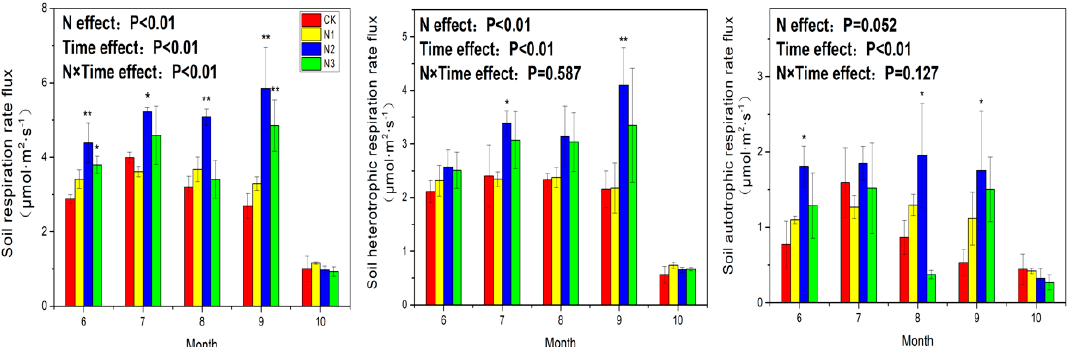
Figure 2. Responses of soil respiration to N application in a subalpine coniferous forest. * indicates a significant di ff erence between N treatment and control ( p < 0.05), ** indicates an extremely significant di ff erence between N treatment and control ( p < 0.01) (Repeated measures ANOVA, LSD multiple